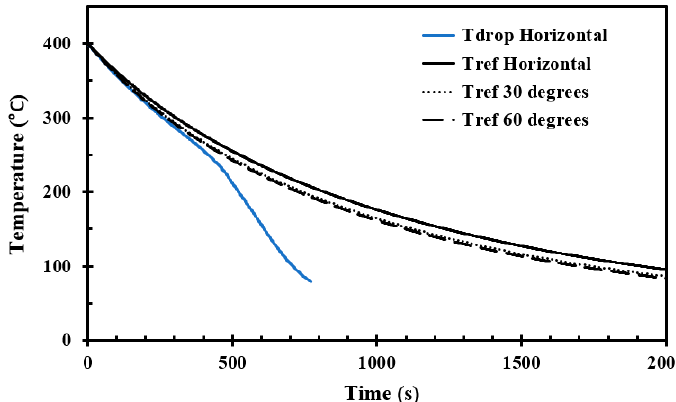
Figure 4. Temperature versus time for a representative stainless steel disc with 2.4 mm diameter droplets and 25 cm impingement height, including reference (dry-cooling) recordings for horizontal, 30° and 60°.